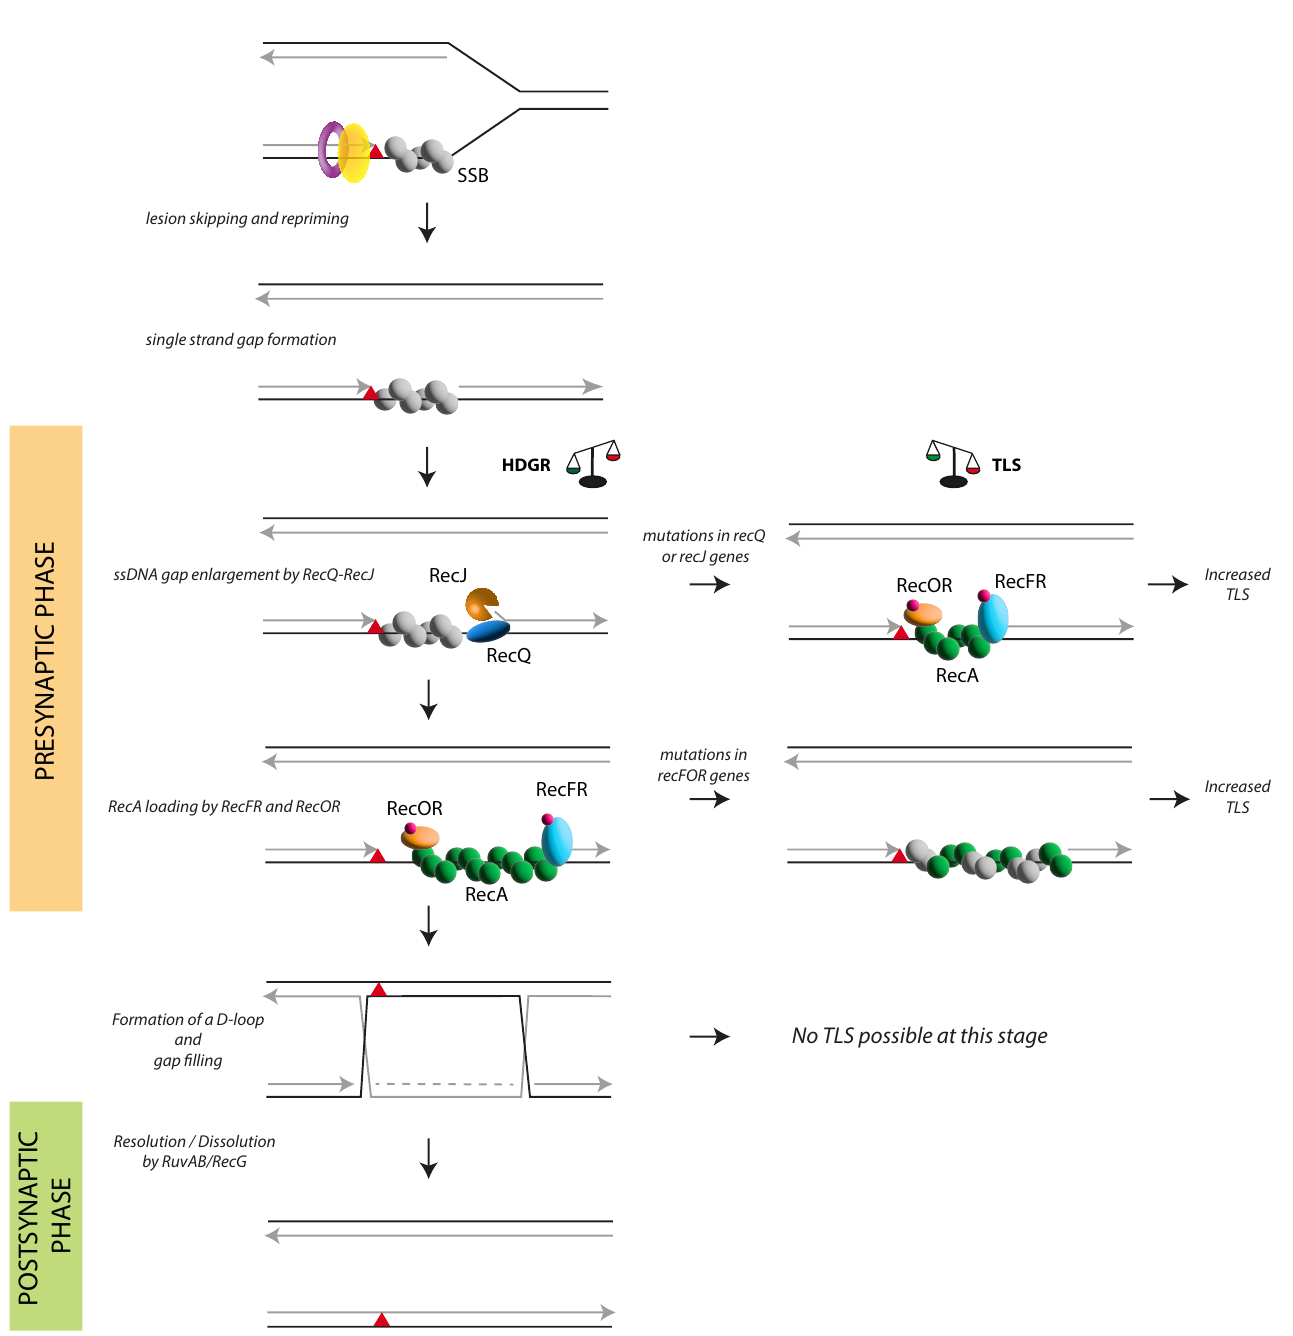
Fig 4. The presynaptic phase of the RecF pathway modulates lesion tolerance pathways. Here is represented a scheme of single strand gap repair, with a particular focus on the presynaptic phase of the RecF pathway. A replication-blocking lesion (red triangle) is positioned on the leading strand. During replication, unrepaired lesions can temporarily block the replicative polymerase. The polymerase can skip the lesion and restart replication downstream, leaving a ssDNA gap that is immediately covered by SSB proteins. From this moment on, the presynaptic phase of the RecF pathway takes place: first the helicase RecQ and the nuclease RecJ are loaded at the 5’ ds-ssDNA junction to enlarge the size of the gap, then the RecFR complex together with the RecOR complex are recruited to displace SSB and load the recombinase RecA in the 5’- > 3’ direction on the ssDNA gap. The presynaptic phase ends with the formation of a RecA nucleofilament that will engage in homology search and strand exchange forming a D-loop structure, which in turn leads to the final step of the HDGR mechanism, the post synaptic phase. The competition between HDGR and TLS can occur only during the presynaptic phase: mutations affecting recQ or recJ genes will impact the efficiency of HDGR because of the smaller size of ssDNA gap, in favor of the TLS polymerases. Similarly, in the absence of the RecF, RecO or RecR, RecA loading will occur randomly and the kinetics of filament formation will be slower, resulting in a decrease in HDGR mechanism and in an increase in Pol II and Pol IV TLS. The combination of RecF and RecJ (or RecQ) deficiency has an additive effect on HDGR similar to the one observed